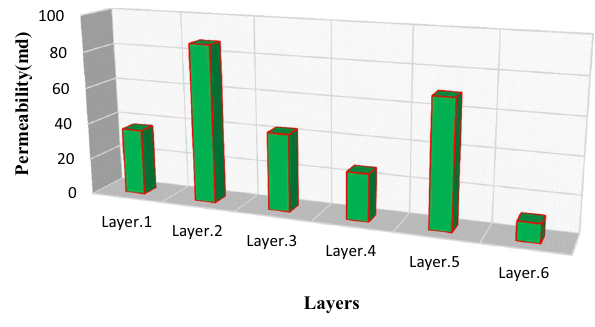
Fig. 6 Permeability measurements by Emeraude software